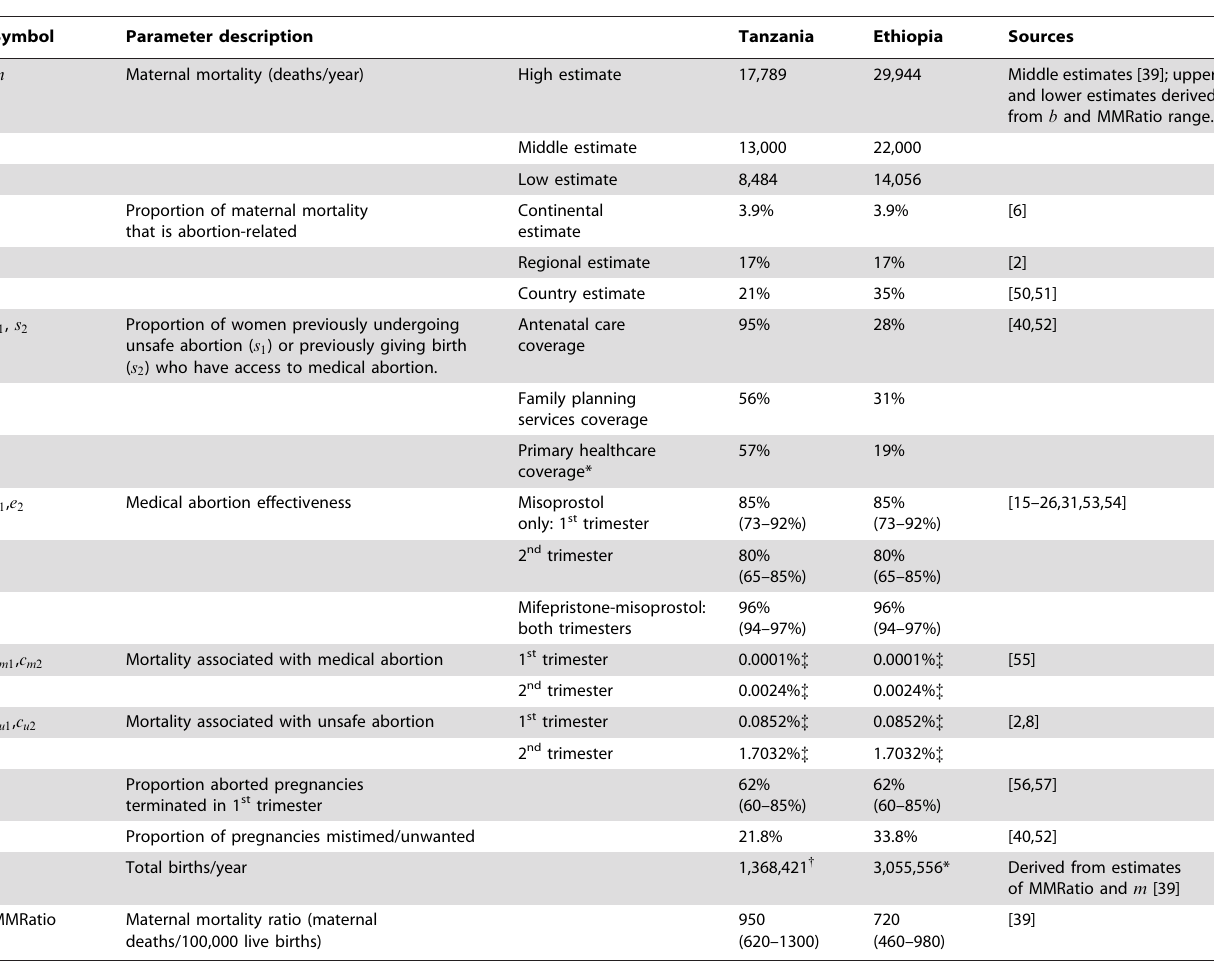
Table 1. Model parameter descriptions and estimates, with sources.